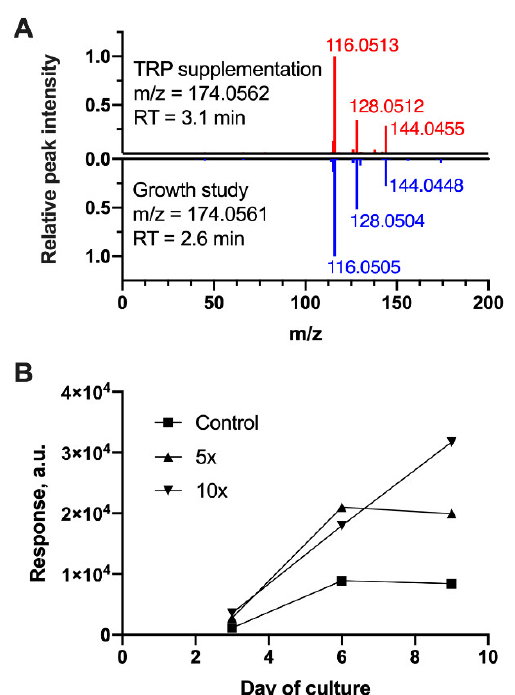
Figure 5. Dose-dependent accumulation of an LC–MS feature in tryptophan (TRP)-supplemented shake flask culture. ( A ) Mirror plot of MS / MS spectrum for the feature detected in TRP-supplemented shake-flask cultures (top spectrum, red peaks) and the feature annotated as 5-hydroxyindoleacetaldehyde (5-HIAAld) in bioreactor cultures (bottom spectrum, blue peaks). m / z : mass-to-charge ratio of precursor ion recorded in the negative ionization mode. RT: chromatographic retention time. ( B ) Response profile of the LC–MS feature shown in the top spectrum of panel ( A ). Response refers to the feature’s area under the curve in extracted ion chromatogram and represents the corresponding metabolite’s concentration in the culture medium. The level of TRP supplementation above the basal medium concentration (control) is indicated in the figure legend. Data shown are the mean ± SD of duplicate cultures. Error bars are smaller than plot symbols.